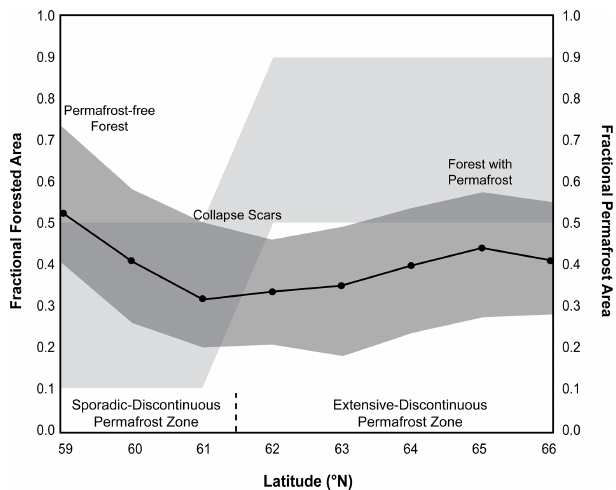
Figure 5. Median forested peatland area expressed as a fraction of the total peatland area and plotted as a function of latitude. The dark grey area represents the range in the proportion of the land- scape occupied by forested peatland (i.e. fractional forested area) between the 25th percentile and 75th percentile. The lighter grey area indicates the range in the proportion of landscape underlain by permafrost (i.e. fractional permafrost area) as indicated by Brown et al.